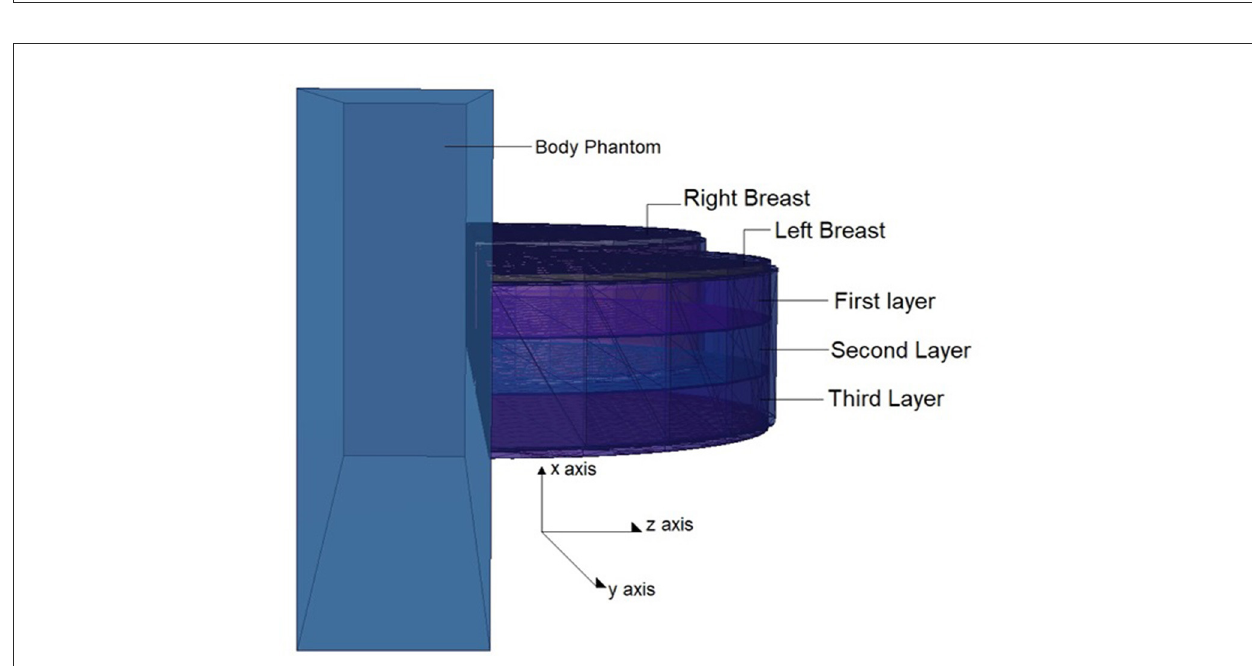
FIGURE3 3-D view of modeled breast phantom along with the positions of breast layers from side view through MCNPX visual